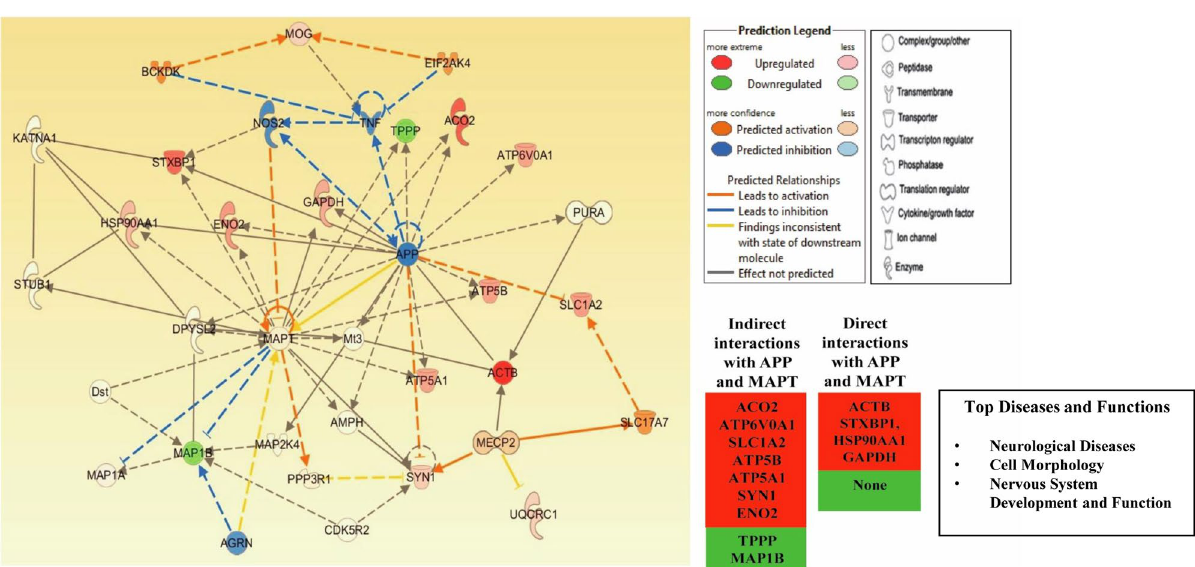
Figure 5. IPA based protein network involved in the development of neurological disorder altering cell morphology and function implicated in AD cortex. The IPA generate networks of differentially expressed proteins and their potential association with other known proteins in AD. The color of proteins indicates their up (red) and down regulated expression in AD in the current dataset, whereas the shapes of the proteins implies their molecular classes as outlined in the legend. Solid lines indicate direct interaction whereas dashed lines correspond to indirect relationship among the interacting proteins. The arrows indicate modulatory effect of a protein on its interacting proteins. APP and MAPT are central to the network creating hubs, interacting with most of the network proteins particularly the focus proteins in the original dataset and regulating them either directly or